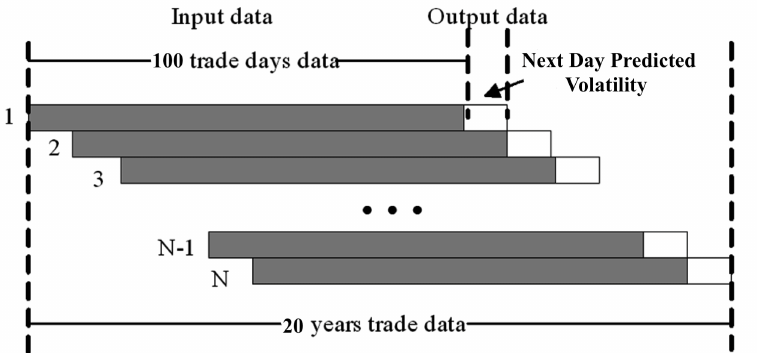
Figure 3. Hybrid GARCH-LSTM algorithm (source: authors’ own elaboration).